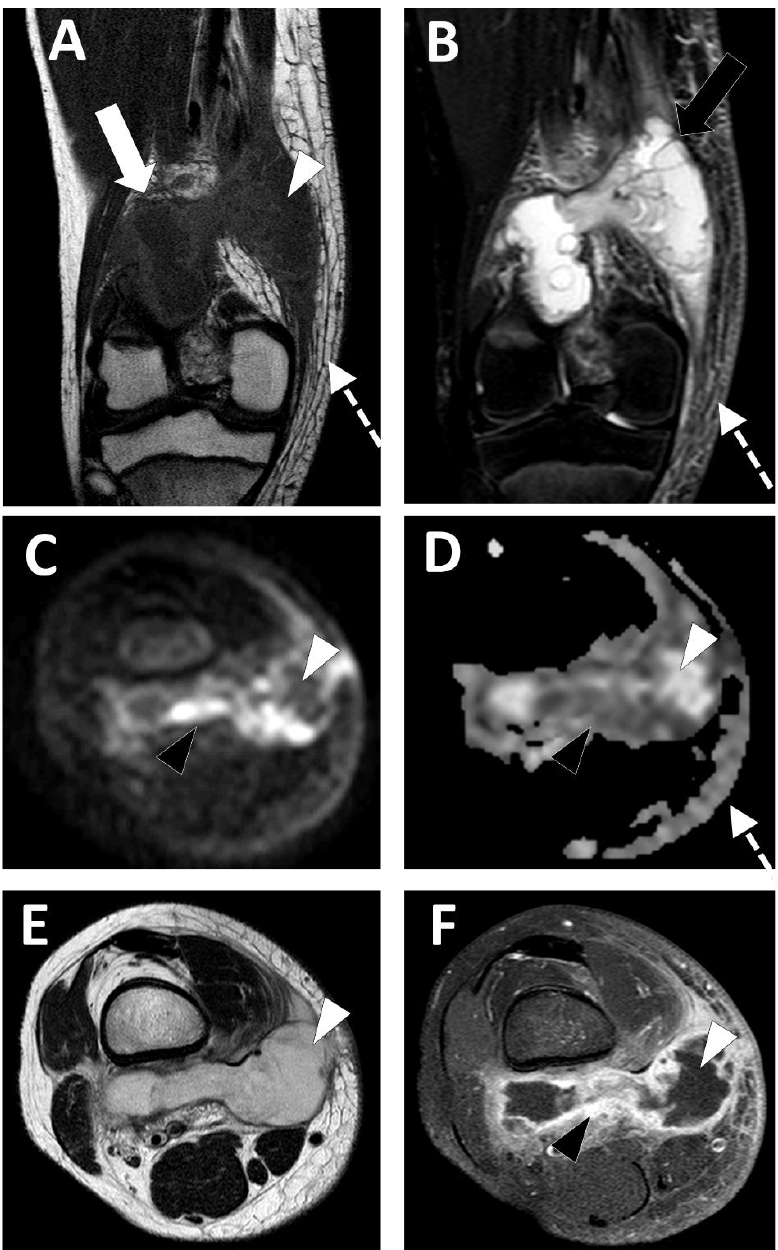
Figure 6. Deep-seated abscess of the right popliteal region in a 13.5-year-old boy presenting with a soft tissue painful swelling, fever, and inflammatory syndrome on blood analysis. The MRI comprises the following sequences: ( A ) coronal T1-weighted imaging (WI), ( B ) coronal T2-WI, ( C ) axial TRACE of diffusion MRI, ( D ) apparent diffusion coefficient (ADC) map, ( E ) axial T2, and ( F ) axial T1 with gadolinium chelate injection and fat suppression. On MRI, the abscess is presented as a fluid-like collection (white arrowhead) with high signal intensity (SI) on T2-WI, low SI on T1-WI, low SI on TRACE, and high ADC value and no contrast enhancement.